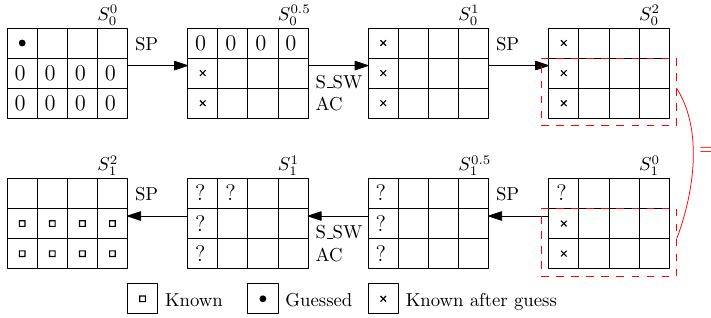
Figure 11: Illustration of the preimage attack on 2-round